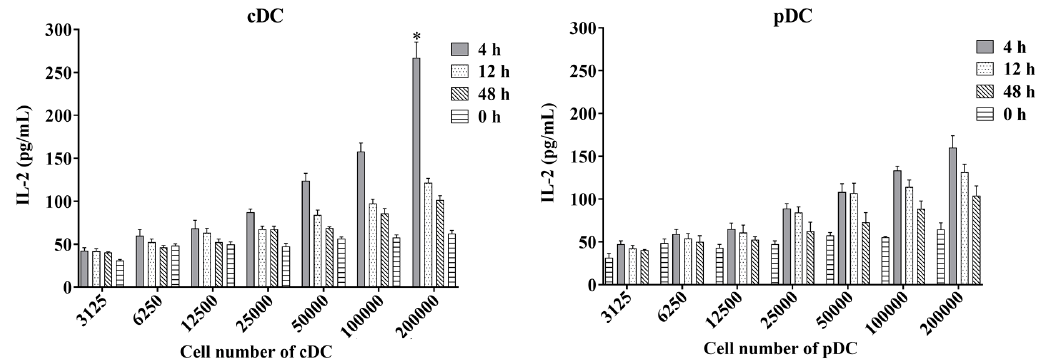
Figure 5. Antigen-presenting activity of mouse splenic cDC and pDC measured using the ex vivo assay. Murine splenic cDCs and pDCs from mice immunized with the mycobacteria-derived Ag85A protein at different time points were used to directly stimulate DE10, a T cell hybridoma, at 37 °C with 5% CO 2 for 24 h. The amount of IL-2 in culture supernatants was determined using sandwich ELISA and a standard curve generated from recombinant IL-2. The experiment was repeated two times and data are shown with the mean value of the two independent experiments. * P < 0.05.